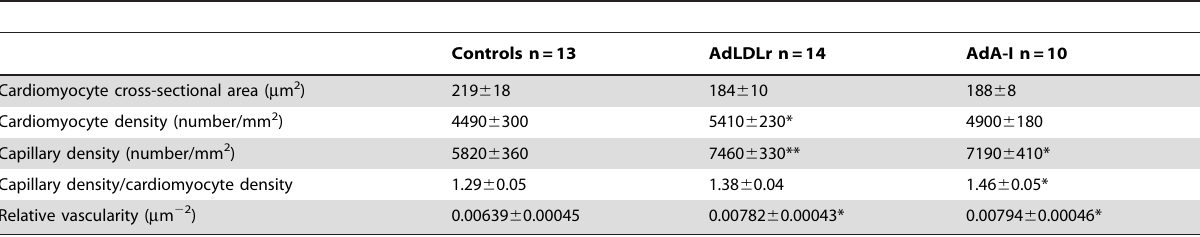
Table 2. Morphometric analysis of the myocardium in C57BL/6 LDLr 2 / 2 mice 6 weeks after saline injection or gene transfer with Adnull (controls), gene transfer with AdLDLr, and gene transfer with AdA-I.